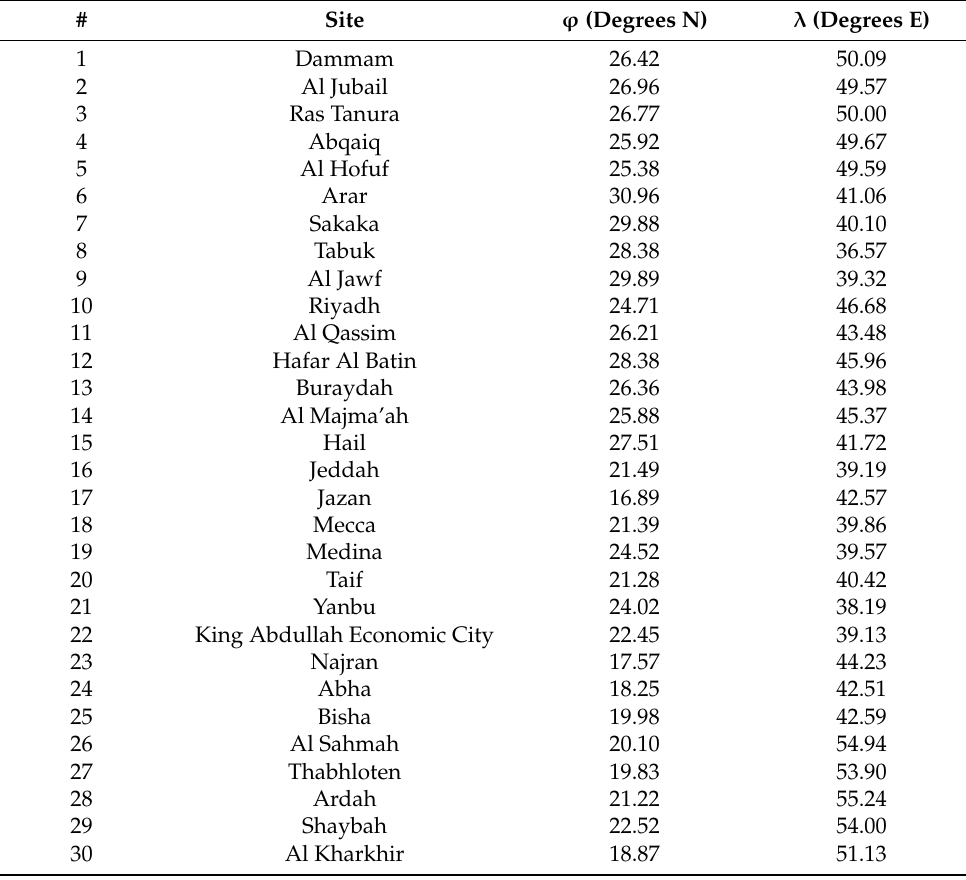
Table 1. The 82 sites arbitrarily selected over Saudi Arabia to cover the whole area of the country; ϕ is the geographical latitude, and λ the geographical longitude in the WGS84 geodetic system. The “unnamed” sites refer to those away from known locations. This table is a reproduction of Table 1 in [1,2]. N = North, E =